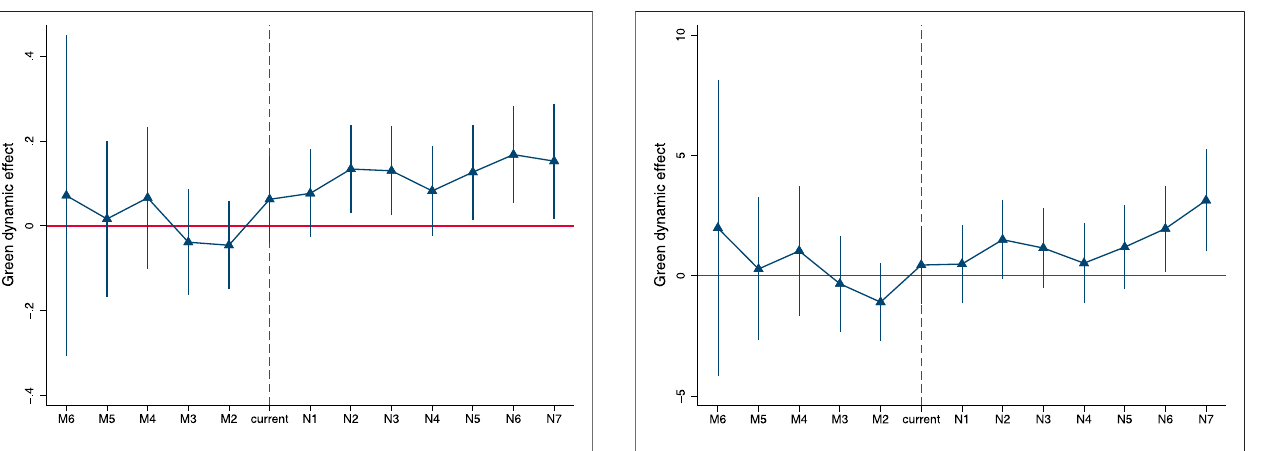
FIGURE 5 | Parallel trend test result of clean power